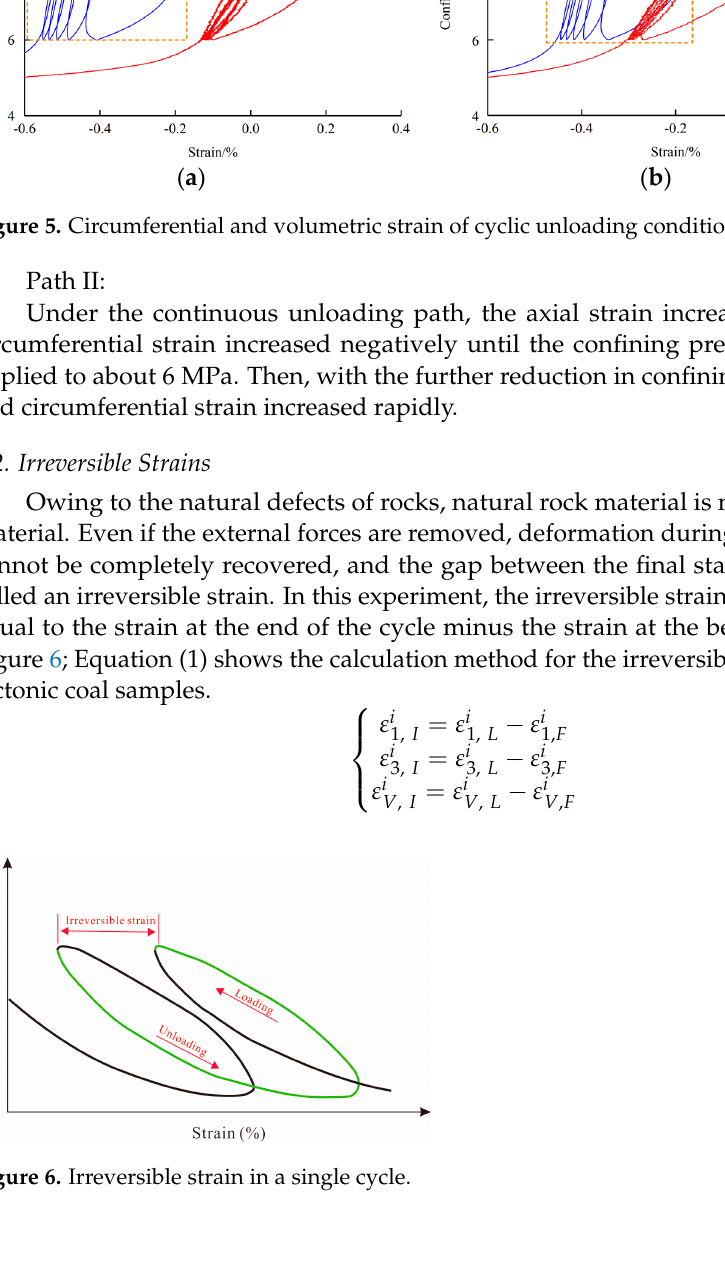
Figure 6. Irreversible strain in a single cycle.